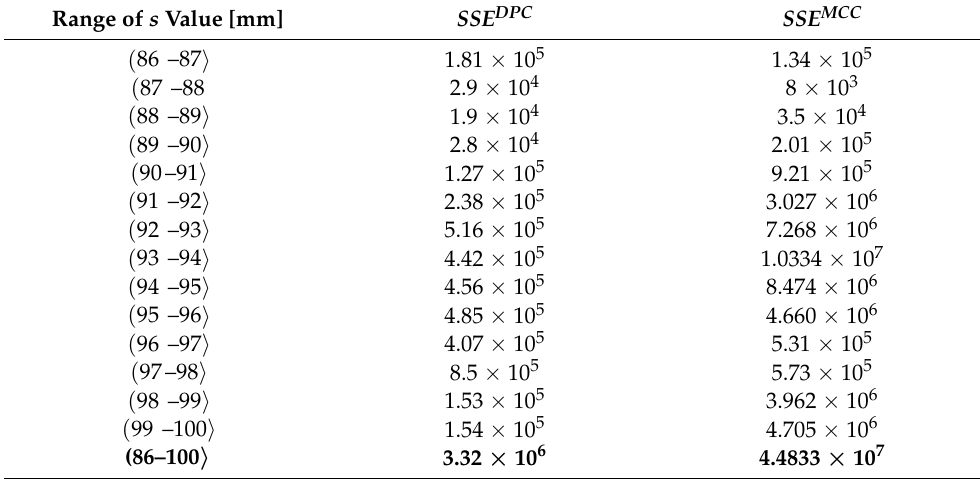
Table 3. SSE values.